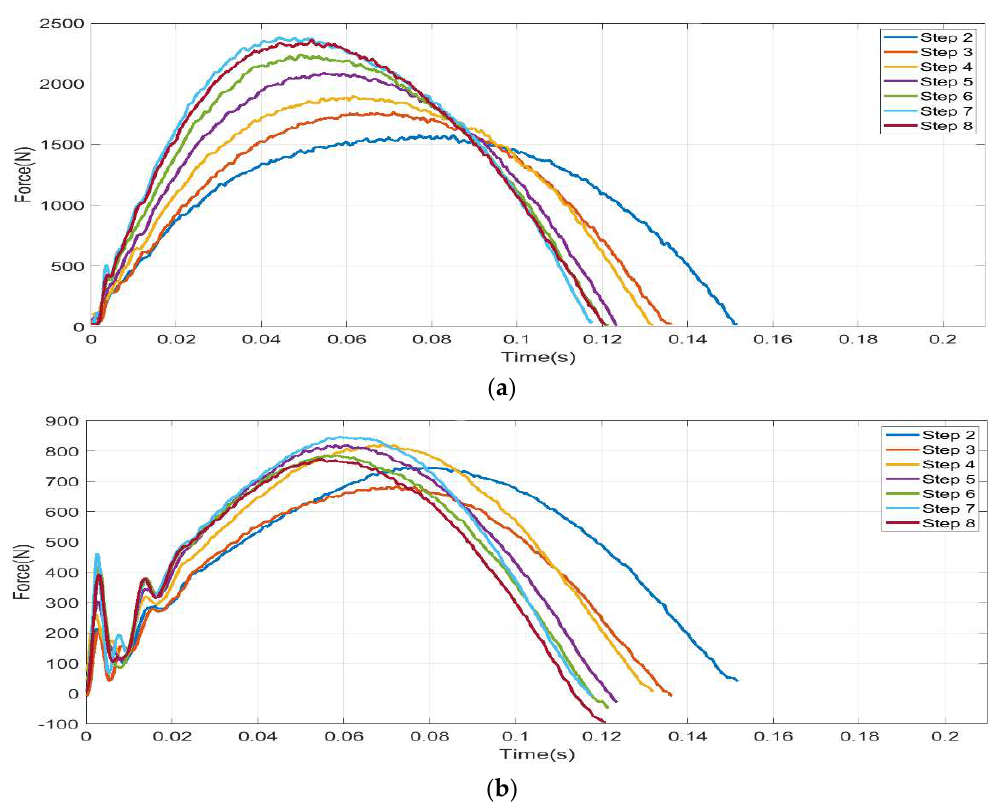
Figure 14. The application of iRPF for multiple step GRF collection with TT1: in the Foot Clamp Reference system, right steps from 2 to 8 are compared during acceleration phase; ( a ) Y Force component and ( b ) X Force component.